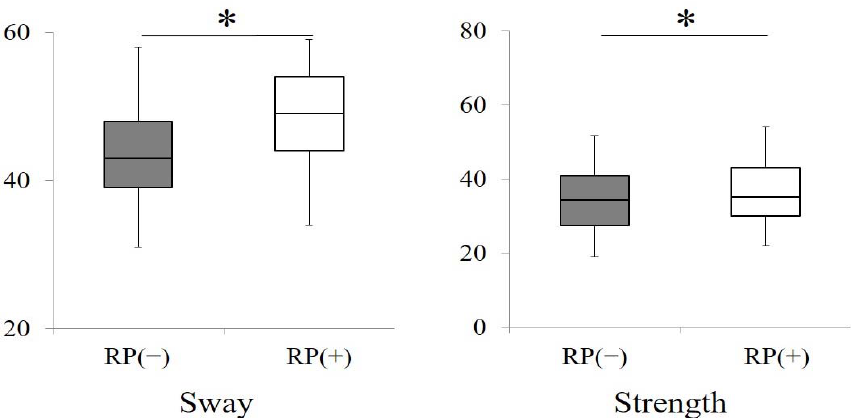
Figure 6. Comparisons of standing motion (sway and strength) between all subjects with and without removable prostheses. (* p < 0.05, Wilcoxon signed-rank test) RP ( − ): subjects without removable prostheses; RP (+): subjects with removable prostheses.